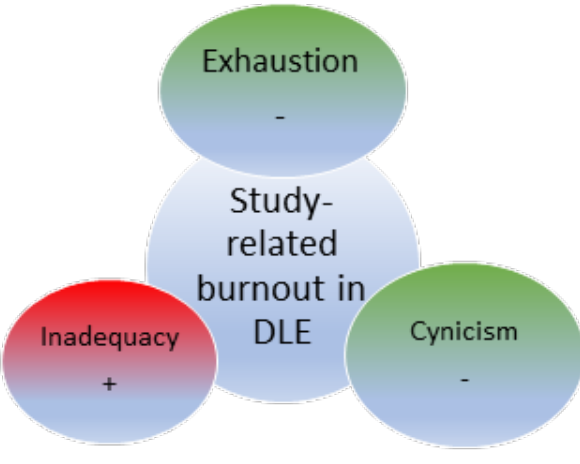
Study-related Burnout in Digital Learning